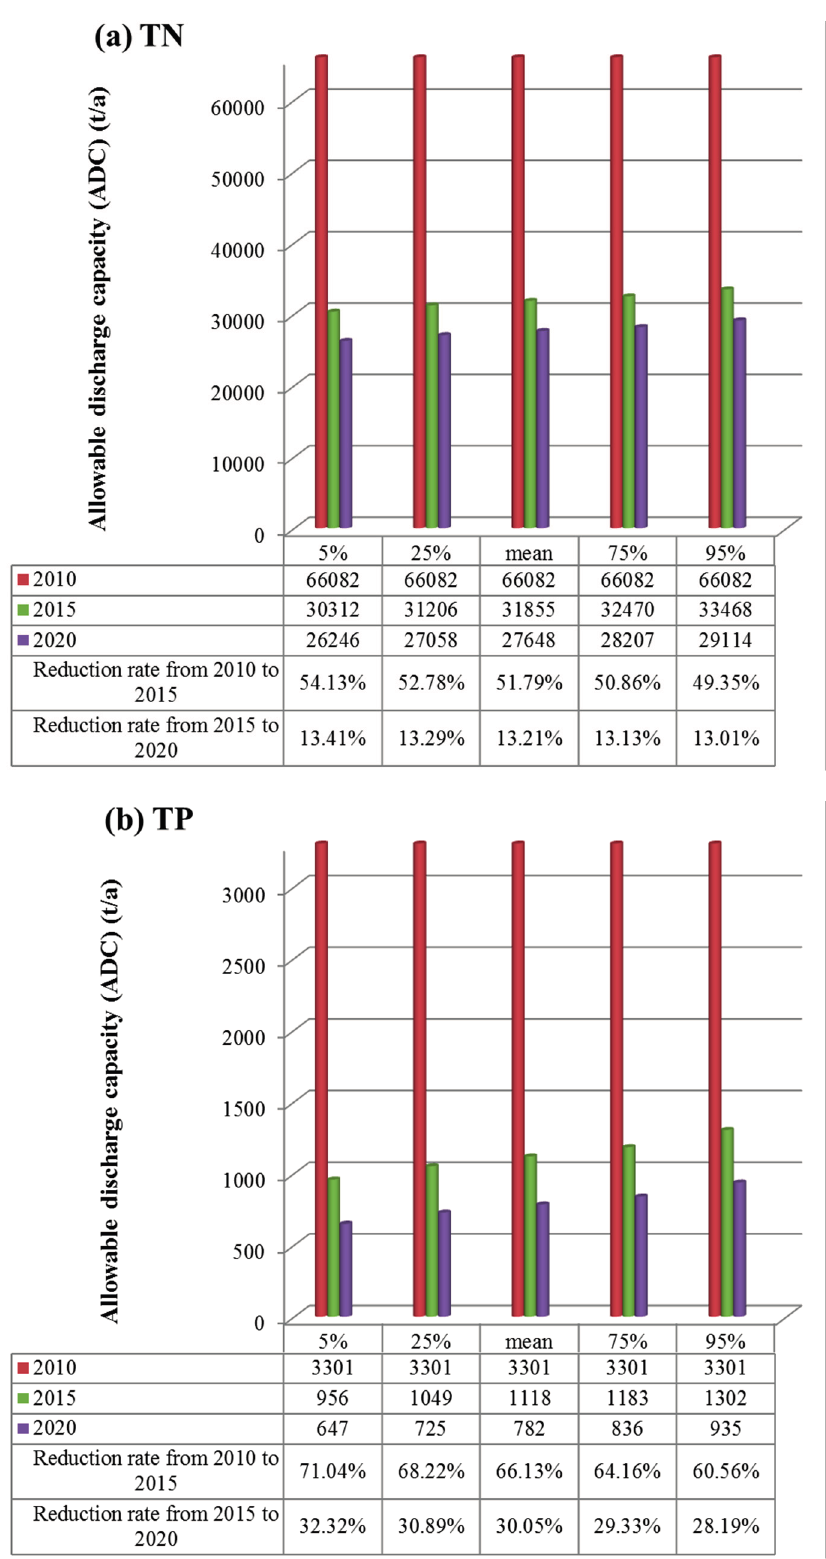
Figure 2. ADC in 2015 and 2020 and corresponding reduction ratio at different confidence levels for TN ( a ) and TP ( b